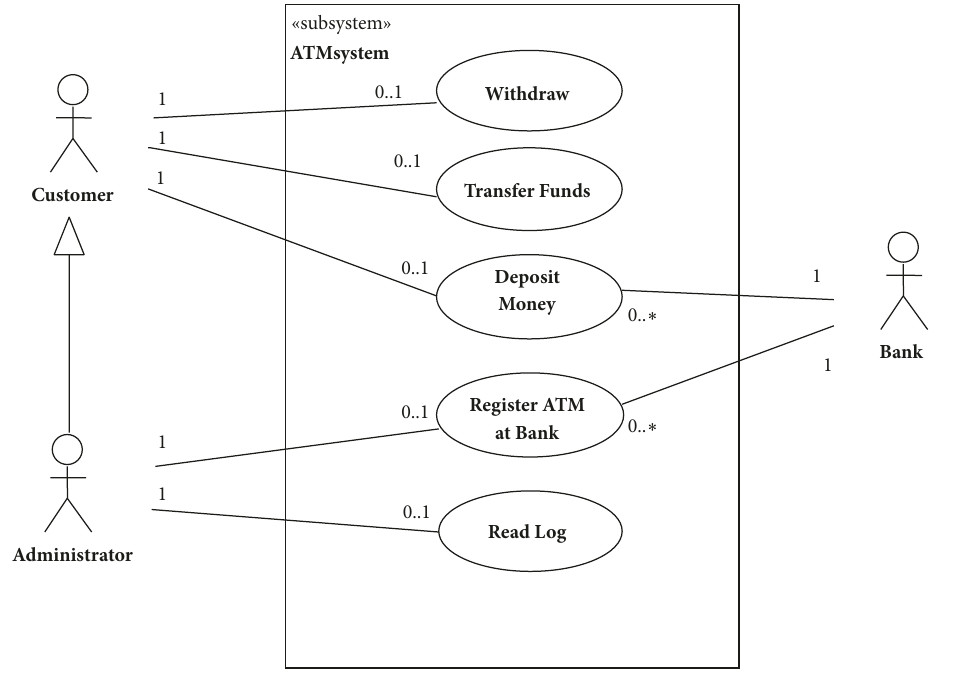
Figure 1: Example of the use cases and actors for an ATM system .